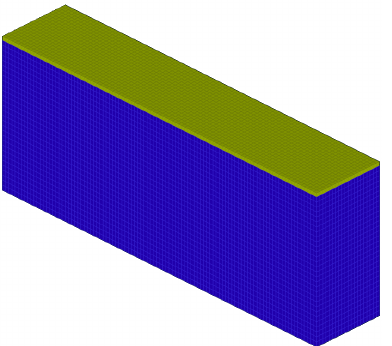
Figure 4. Finite element mesh view of polymer specimen with spraying.